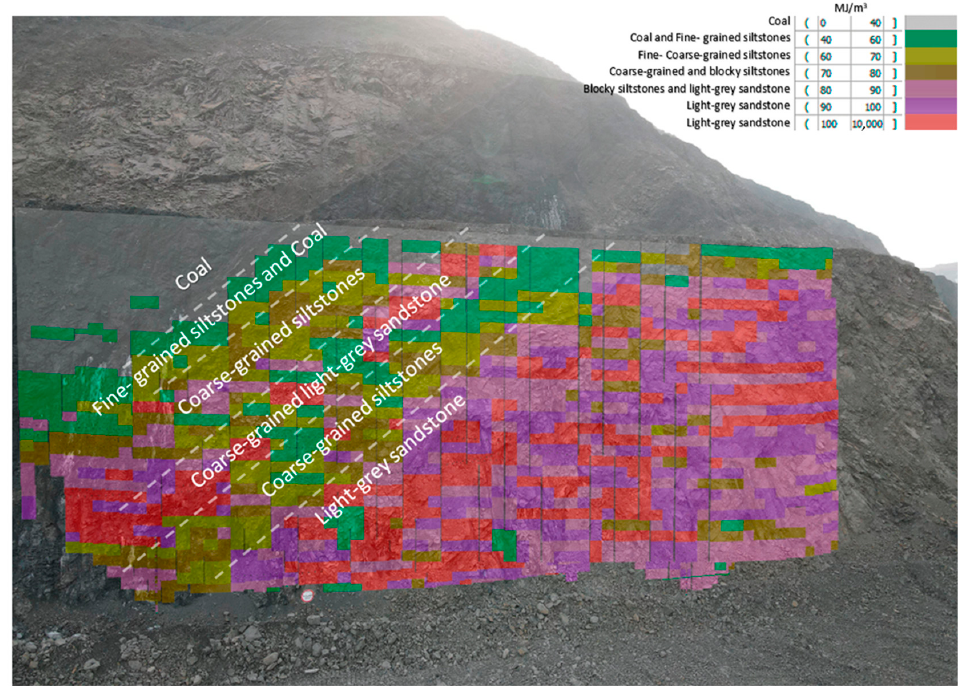
Figure 9. The block model of MSE for blast hole in the pre-split row, built-in GIS “Goemix” software based on measured drilling parameters.